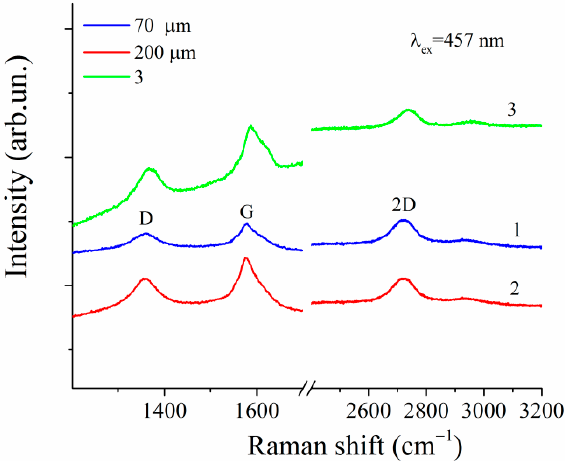
Figure 3. Raman spectra of oxidized multilayered graphene particles are recorded with spectrom ‐ eter slit width 70 ( 1 ) and 200 μ m ( 2 ). Spectrum of single ‐ layer graphene ( 3 ) was taken from